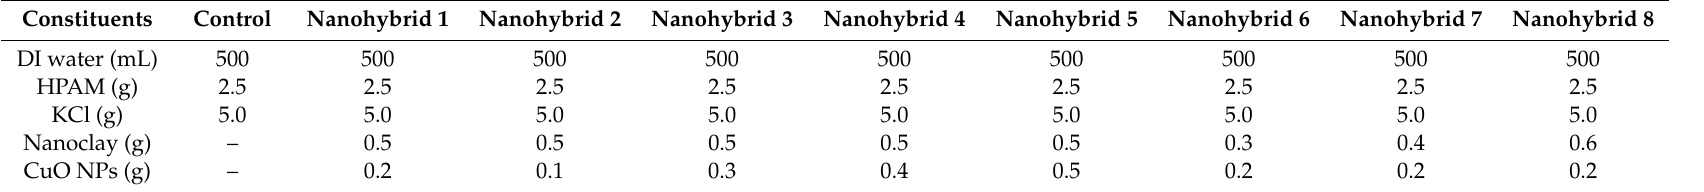
Table 2. Composition of the polymer solution (control) and the nanohybrid systems used in this